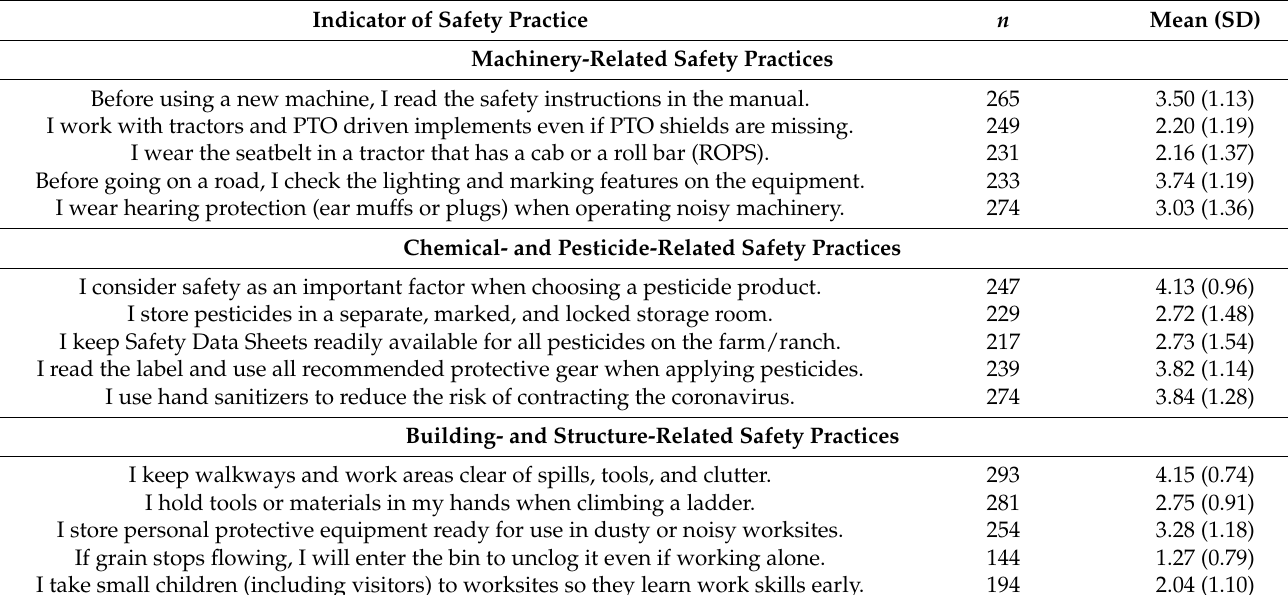
Table 2. Means and standard deviations (SDs) of self-reported safety practices * on farm or ranch operations in the central states region of the US, 2021.